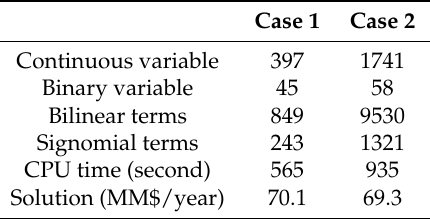
Table 5. Summary of model statistics for case 1 and case